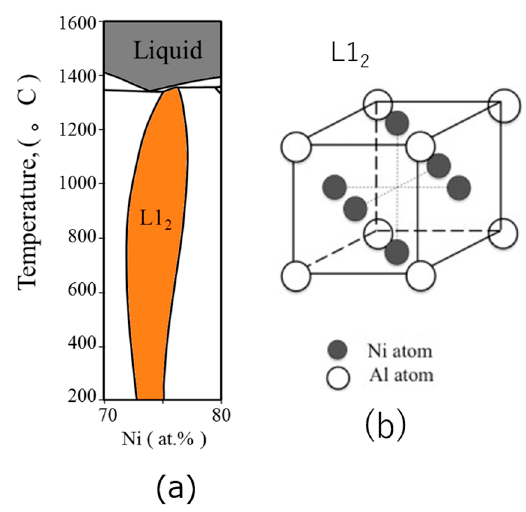
Figure 20. ( a ) Phase diagram for Ni-Al binary alloy and ( b ) schematic diagram of L1 2 structure.